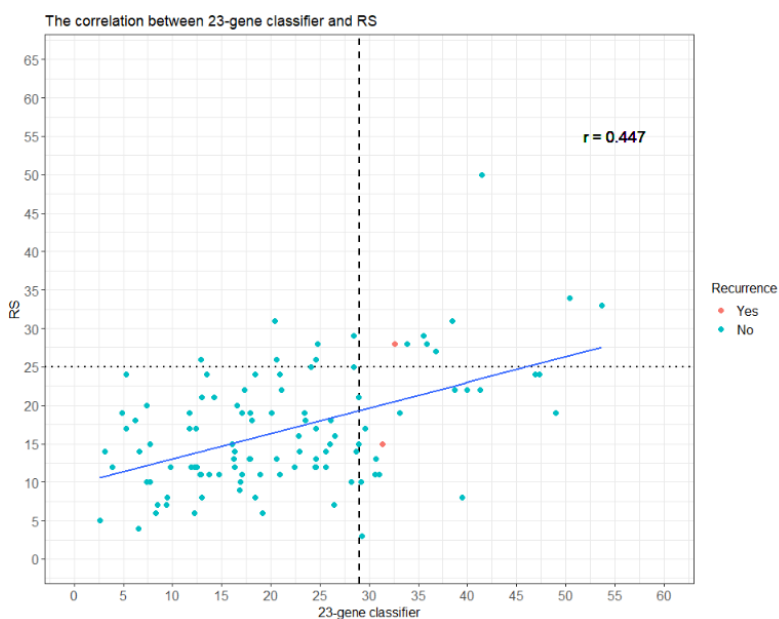
Figure 2. Scatter plot for 23-gene classifier RI and Oncotype DX ® RS. Diagnostics 2022 , 12 , x FOR PEER REVIEW